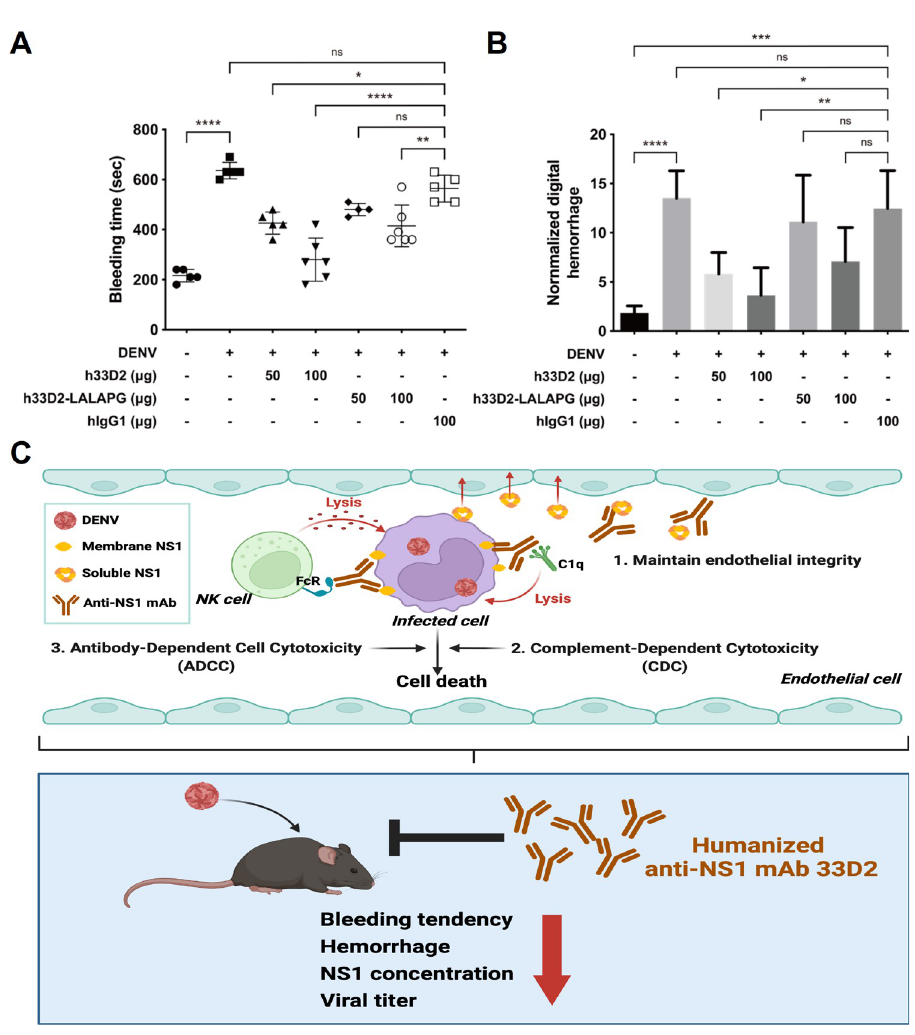
Fig 8. Effects of humanized anti-NS1 mAb 33D2 and 33D2-LALAPG on DENV-induced prolonged bleeding time and skin hemorrhage. 1 × 10 7 PFU/mouse DENV2-454009A or C6/36 control medium were inoculated i.d. into the upper back of STAT1 -/- mice. The mAbs h33D2, h33D2-LALAPG or isotype control hIgG1 (50 or 100 μ g/mouse) were injected i.p. one day after virus challenge. ( A ) Tail bleeding time was determined on 5 d.p.i. ( B ) The degree of hemorrhage was quantified by ImageJ software analysis as described in the methods. (n = 6 for the 100 μ g h33D2-treated and h33D2-LALAPG-treated groups, n = 4 for the 50 μ g h33D2-LALAPG-treated group, and n = 5 for other groups) � : p < 0.05, �� : p < 0.01, ��� : p < 0.001, ���� : p < 0.0001, ns indicates not significant. Statistical significance was based on one-way ANOVA followed by Tukey’s multiple comparison test. ( C ) The schematic model shows that anti-NS1 mAbs block NS1-induced hyperpermeability to maintain endothelial integrity as well as trigger complement-mediated cytotoxicity (CDC) and antibody-dependent cellular cytotoxicity (ADCC) to cause infected cell death. Hence, in the mouse model, anti-NS1 mAbs not only reduce DENV-induced prolonged bleeding time and hemorrhage, but also reduce serum viral titer and soluble NS1 level. This figure is created with